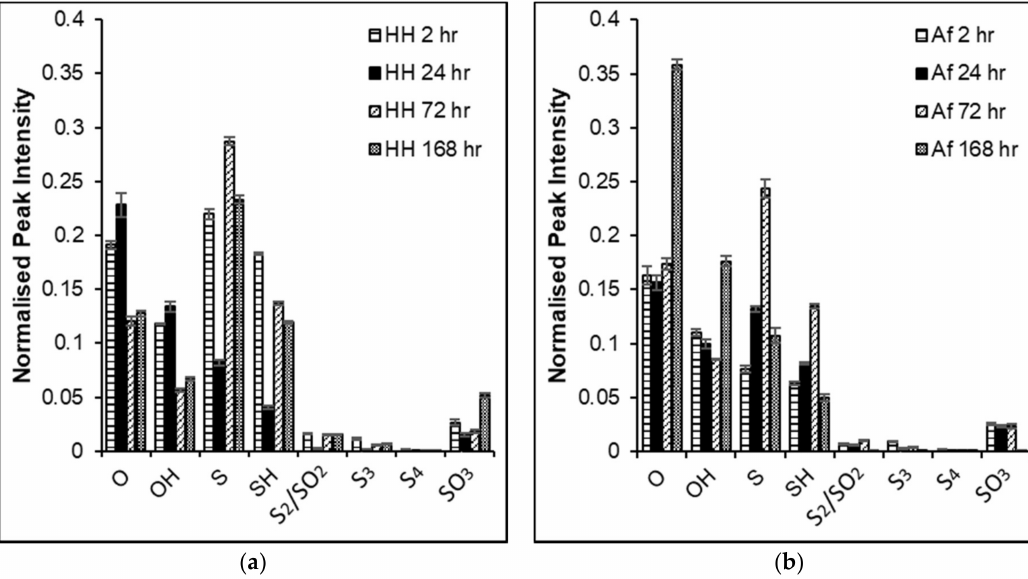
Figure 7. ToF-SIMS normalised peak intensities of negative ion fragments of pyrite exposed: ( a ) HH medium for 2, 24, 72 and 168 h; ( b ) A. ferrooxidans for 2, 24, 72 and 168 h. 95% confidence interval where n =